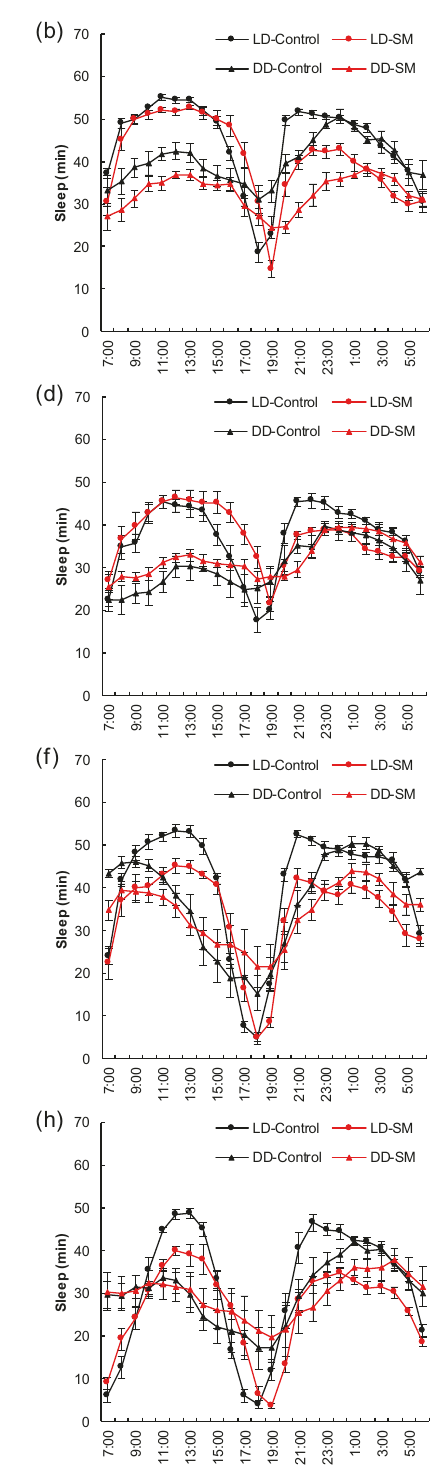
Fig. 1 Activity and sleep rhythms under simulated microgravity under LD and DD conditions. a Activity rhythms of Canton-S males. b Sleep rhythms of Canton-S males. c Activity rhythms of Canton-S females. d Sleep rhythms of Canton-S females. e Activity rhythms of w1118 males. f Sleep rhythms of w1118 males. g Activity rhythms of w1118 females. h Sleep rhythms of w1118 females. Data were calculated by a mean of 3 days. n ≧ 90. Error bars represent standard Therefore, we speculated that the effects of simulated micro- As indicated, the results of activity and sleep patterns of gravity might be affected and adjusted by these factors (strains, Canton-S and w1118 fruit fl y showed that simulated microgravity sexes, light conditions). MANOVA (multi-way analysis of variance) had simple effects on activity and sleep, and these effects varied was performed, and the results showed that there were among in different light conditions (LD/DD), strains, and sexes.